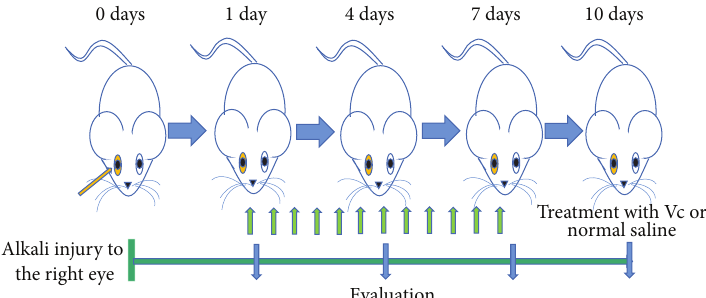
Figure 1: Schematic representation of the time course for the experiments. Days 0 to 10; time after alkali injury (day). Day 0; corneal alkali burns were created in the right eye of mice. From day 1 to 7, the mice were treated with vitamin C. Biomicroscopic and histopathological examinations were conducted on days 1, 4, 7, and 10 after the alkali